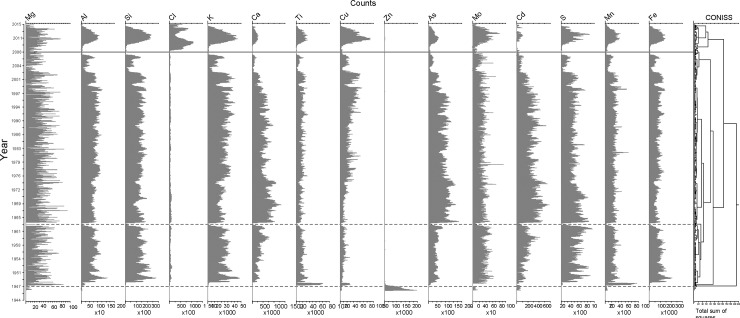
Geochemical analysis of CORE2.Elemental composition of sediment core CORE2 from Inca Coya Lake by XRF analysis and environmental periods identified by CONISS analysis.